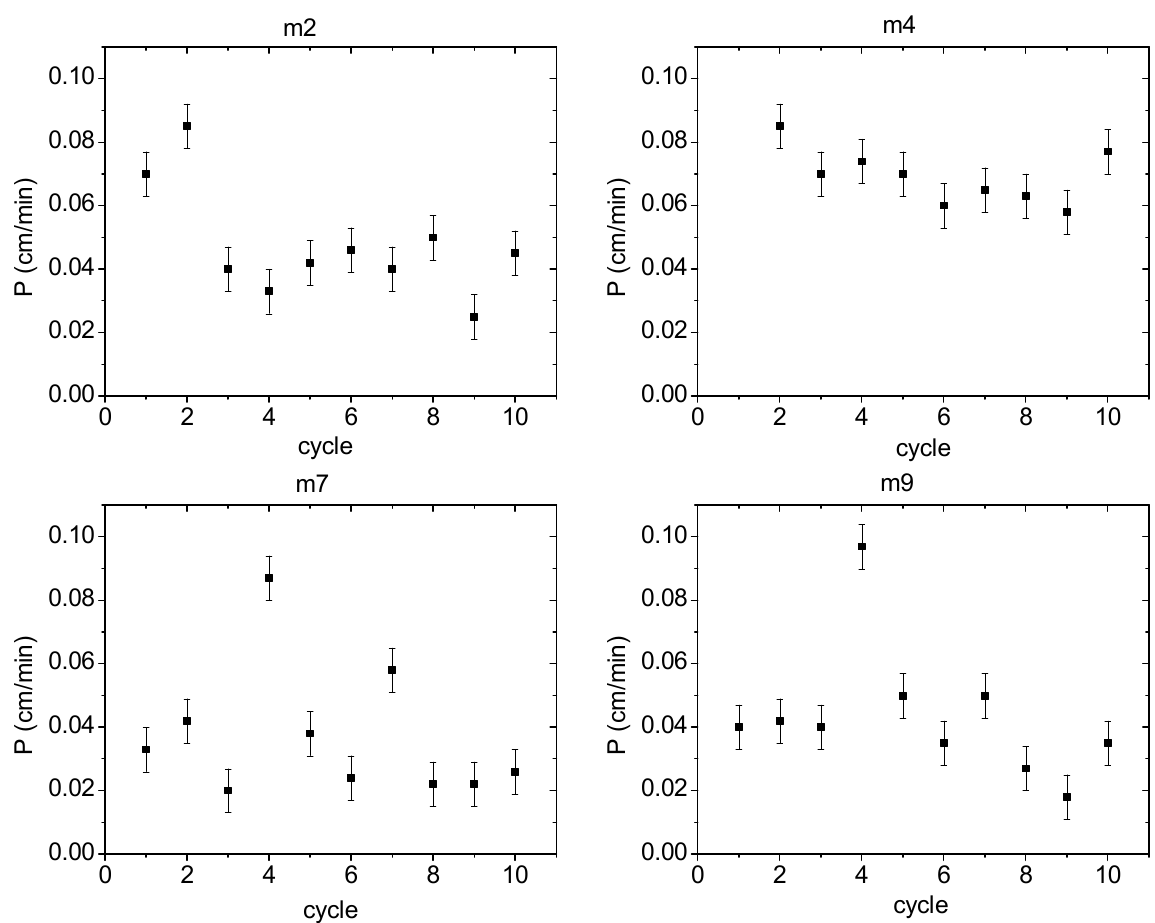
Figure 10. Permeabilities during several operating cycles for PIMs with 2NPOE (m2 (low content) and m4 (high content)) and TBEP (m7 (low content) and m9 (high content)).